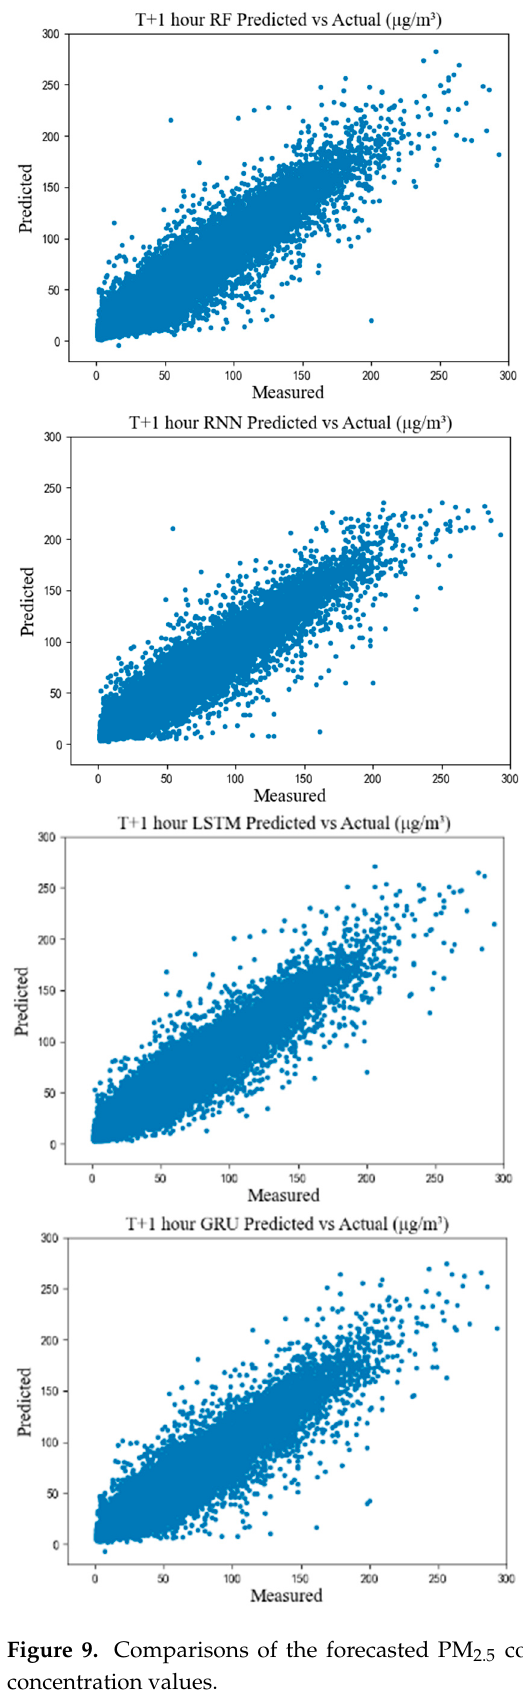
Figure 9. Comparisons of the forecasted PM 2.5 concentration values with the measured PM 2.5 concentration values.